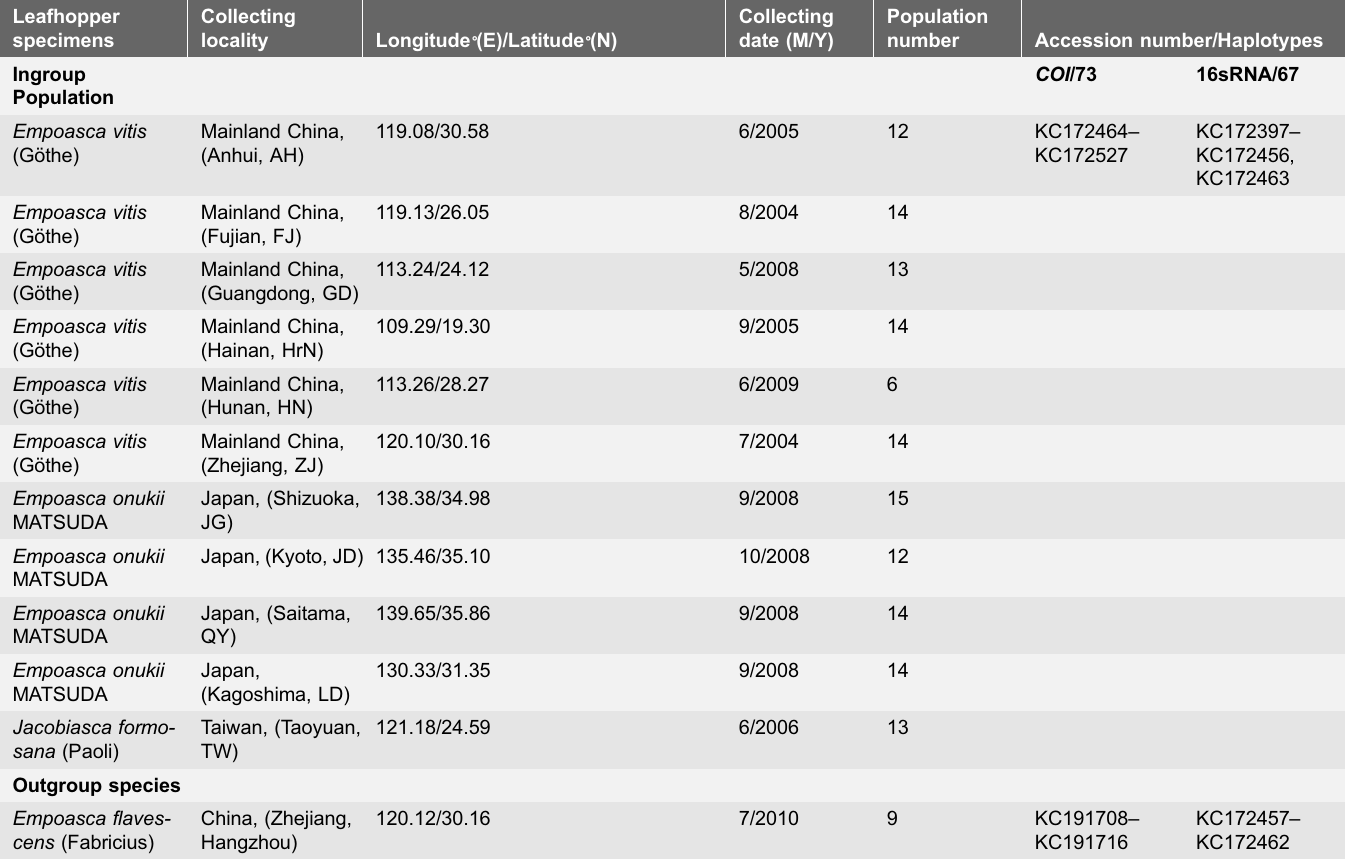
Table 1. The collecting information and bioinformatics for leafhopper specimens. Leafhopper